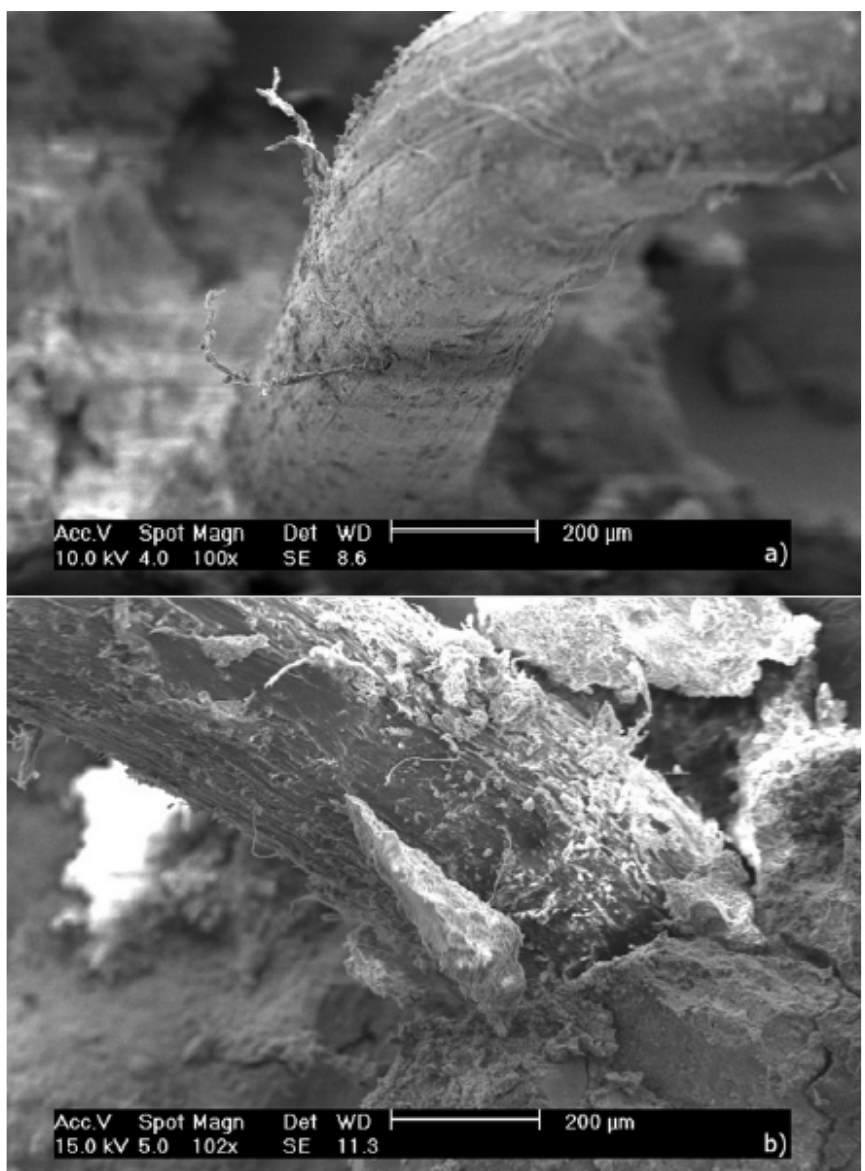
Figure 13. Scan Electronic Microscopy Plastics Waste Fibers ( a ) θ = 0.25 mm and ( b ) θ = 0.40 mm: Used as per Elsevier Permission [40].